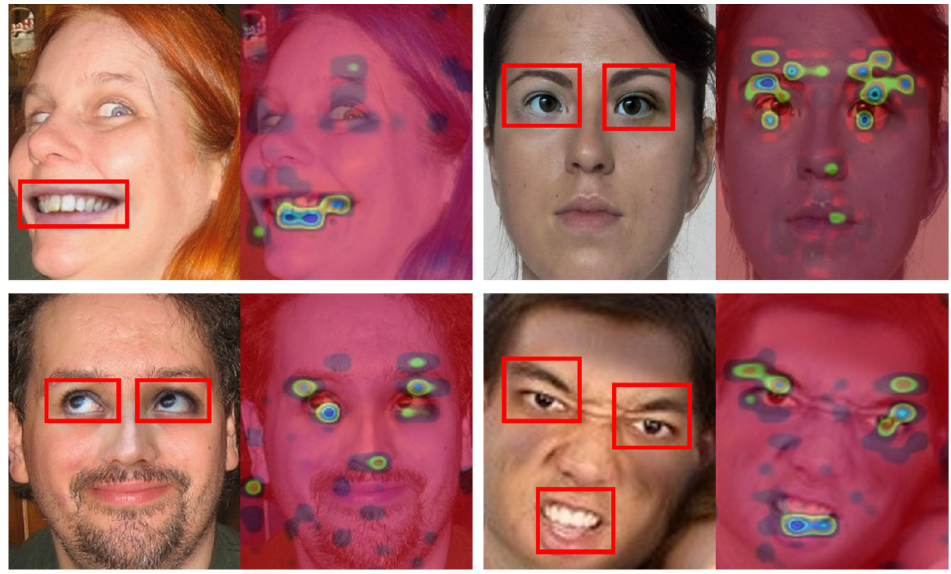
Figure 7. Class activation map (CAM) interpretation of the model predictions.